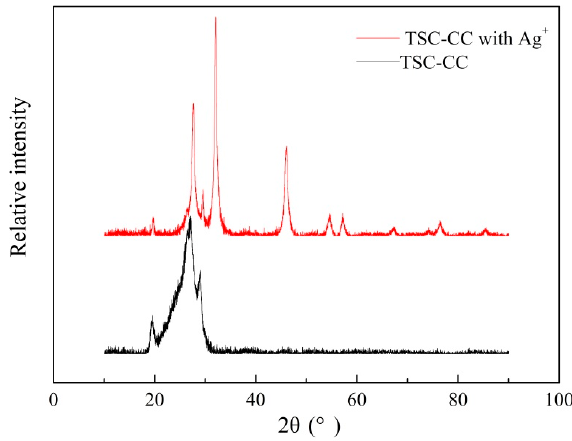
Figure 10. XRD curves of TSC-CC and TSC-CC with Ag + .